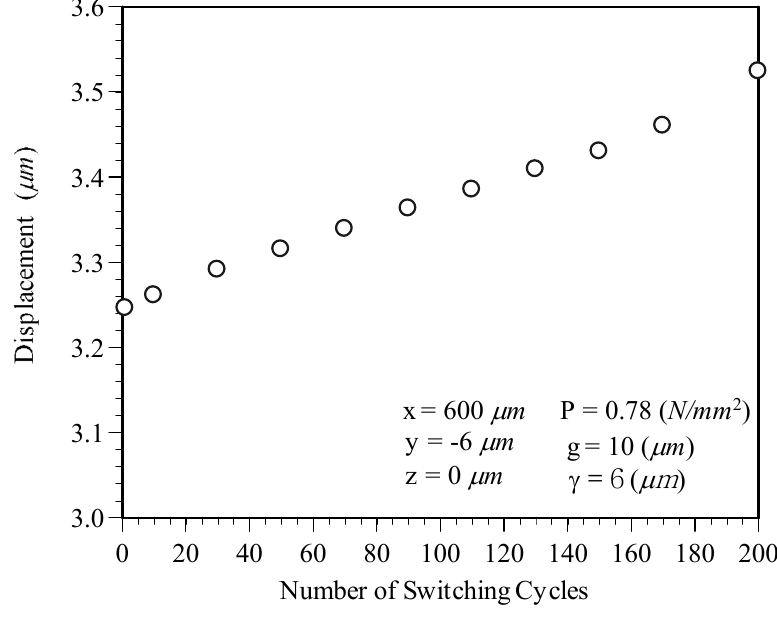
Figure 14. Effect of switching numbers on the maximum contact temperature